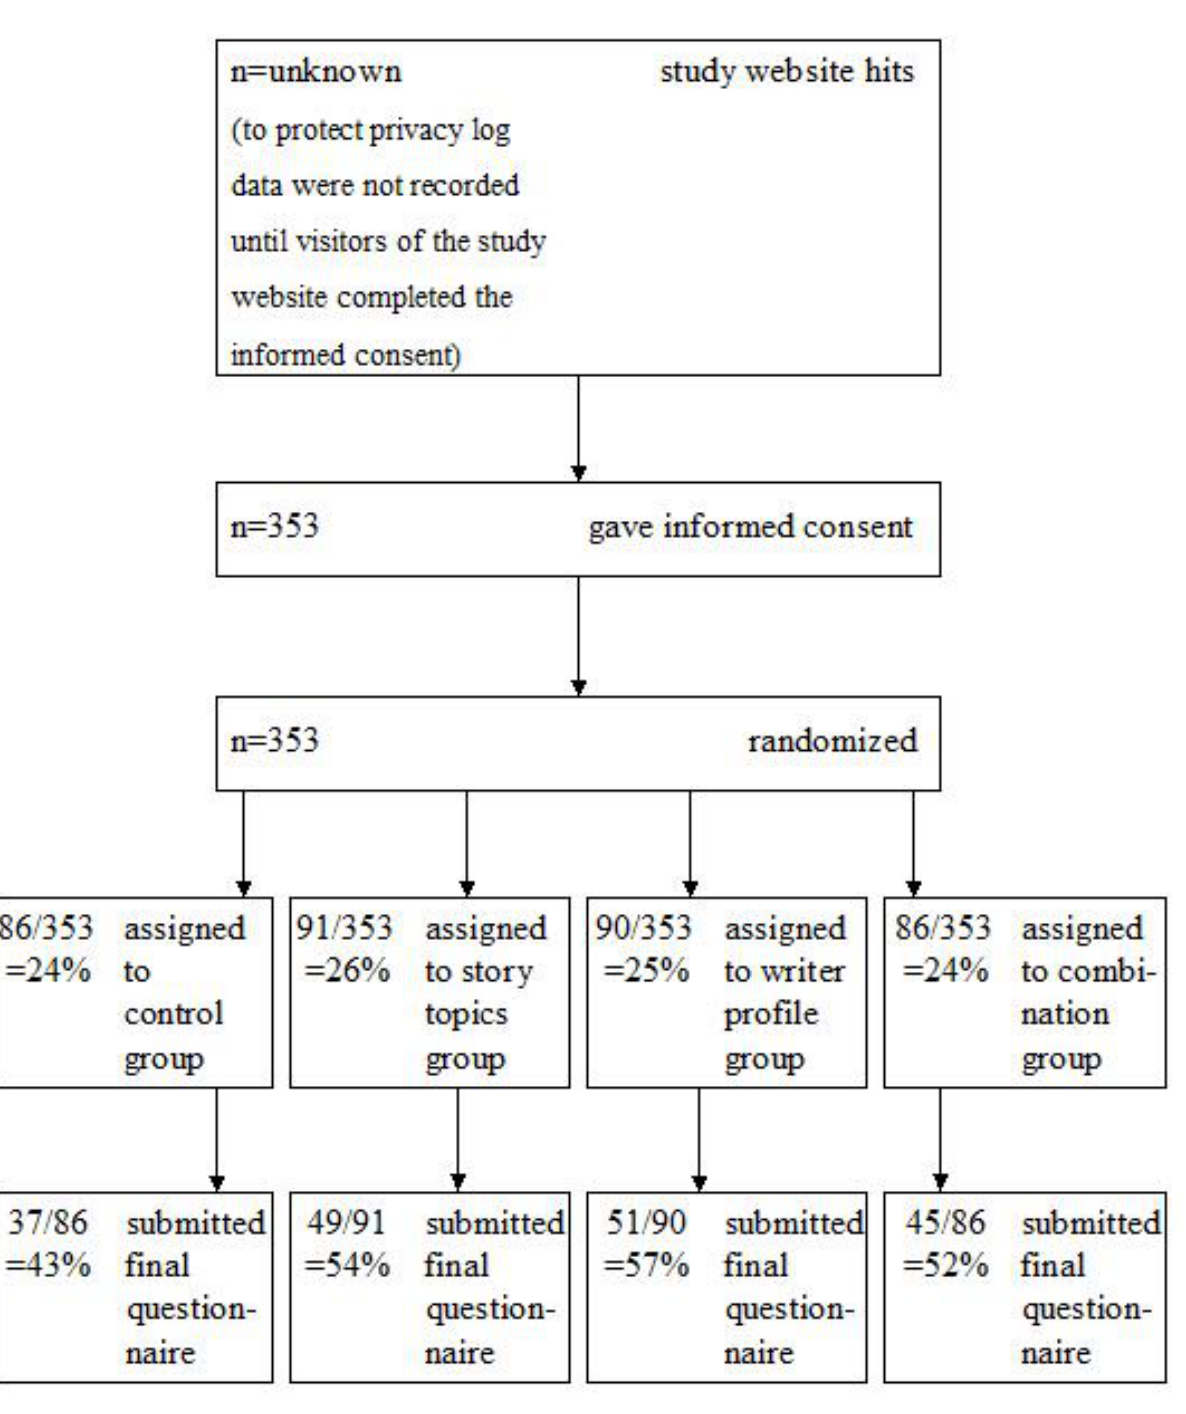
Figure 5. Flow of study